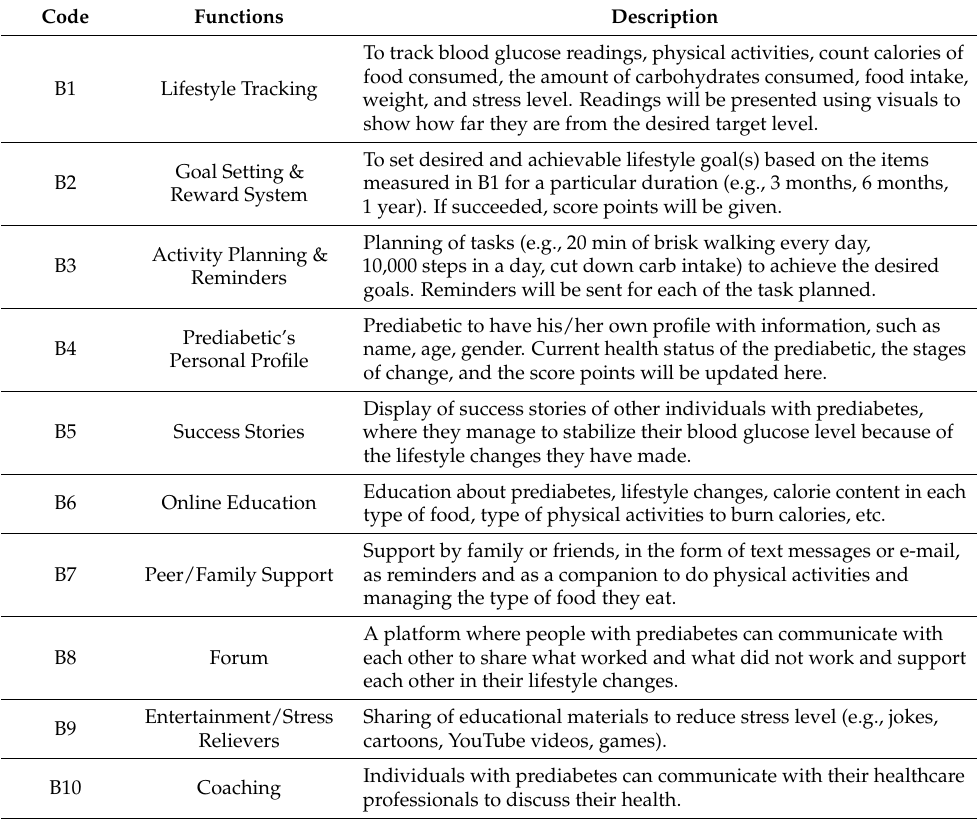
Table 3. BCTs presented as features in